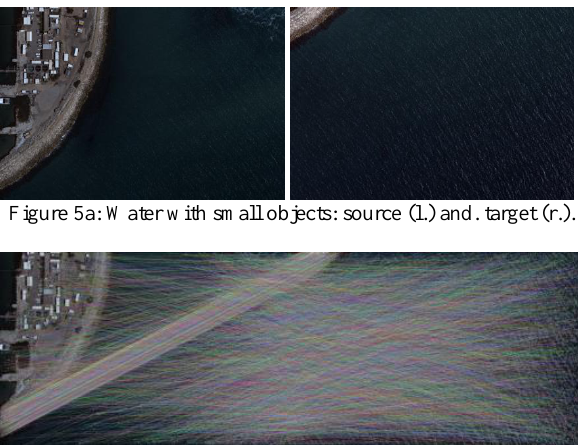
Figure 5b: Candidate matches